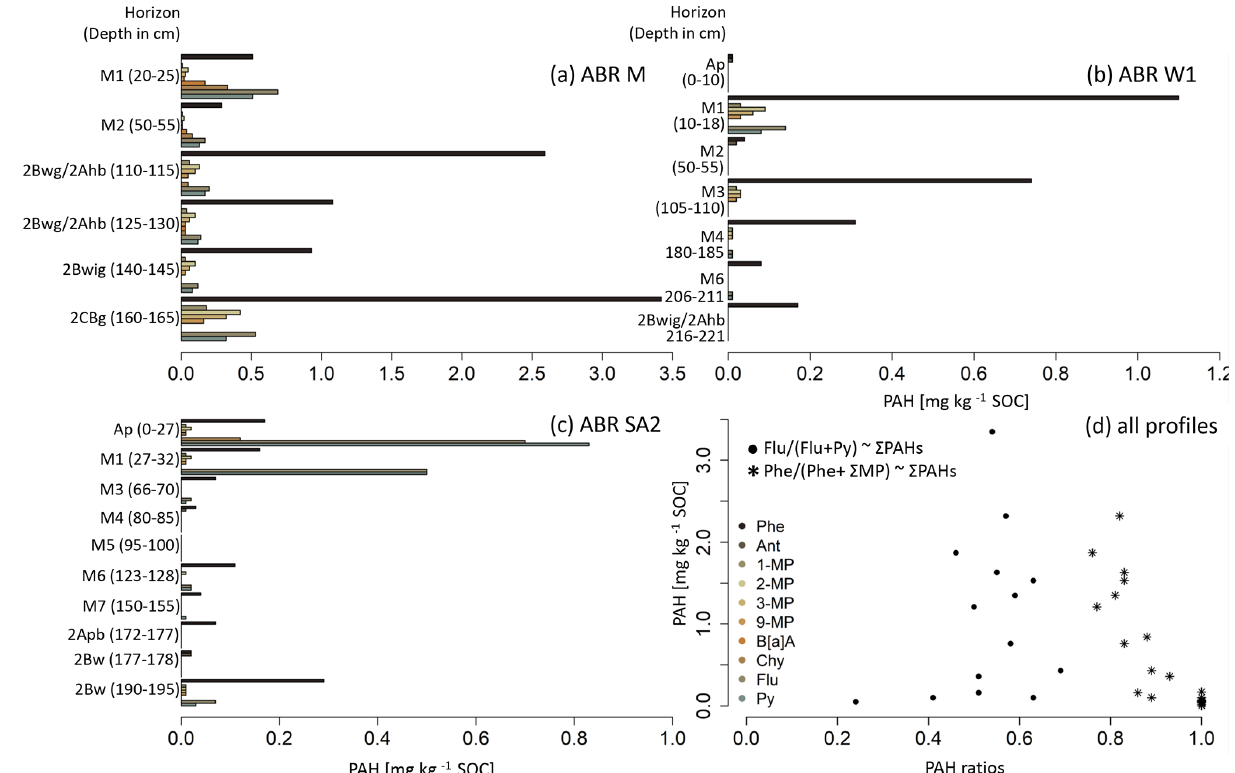
Figure 9. Polycyclic aromatic hydrocarbons (PAHs) with SOC normalization (a–c) of selected colluvial profiles and sampling depths (cm); PAH ratios vs. sum of PAHs (d) . Phe: phenanthrene, Ant: anthracene, 1-MP: 1-methyl-phenanthrene, 2-MP: 2-methyl-phenanthrene, 3-MP: 3-methyl-phenanthrene, 9-MP: 9-methyl-phenanthrene, B [ a ] A: benz [ a ] anthracene, Chy: chrysene, Fl: fluoranthene, Py: